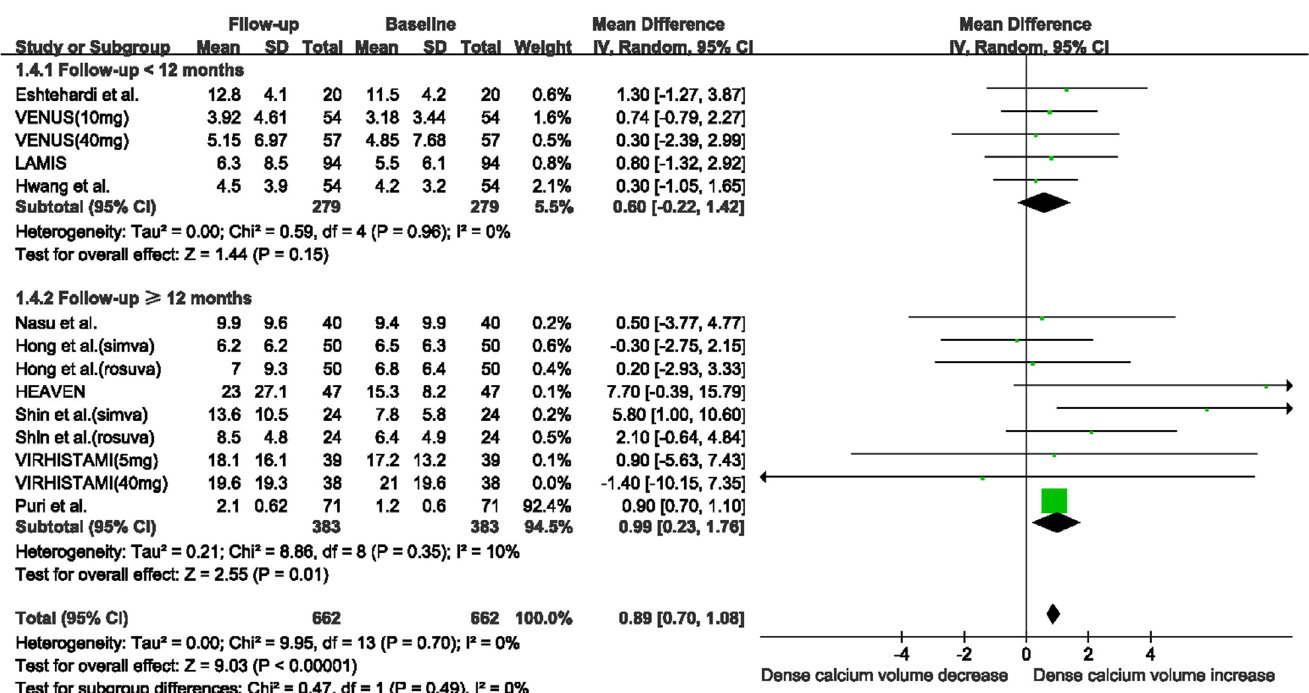
Fig 5. Meta-analysis of changes in dense calcium volume with statin therapy using stratified analysis based on follow-up duration. Abbreviations: CI: confidence interval; SD: standard deviation.